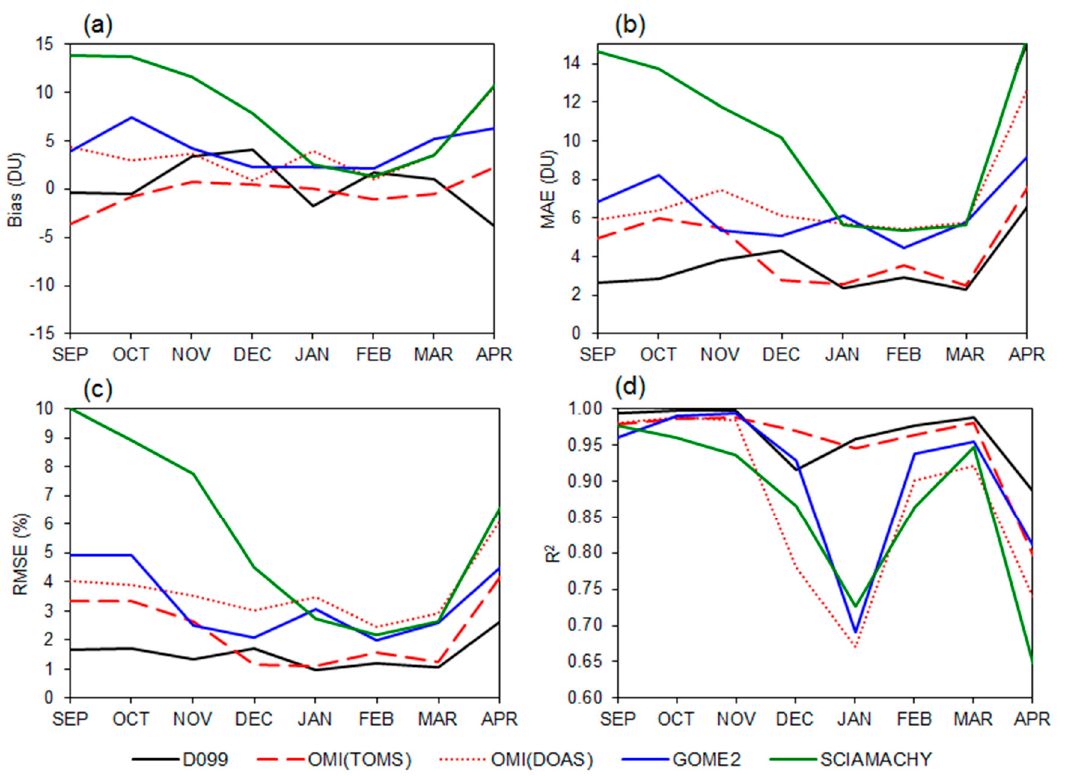
Figure 5. Monthly ( a ) bias, ( b ) MAE, ( c ) RMSE, and ( d ) determination coefficient R 2 of the D099 and the satellite TOC observations relative to the B199 TOC at the Marambio Base for the period 2011– 2013.